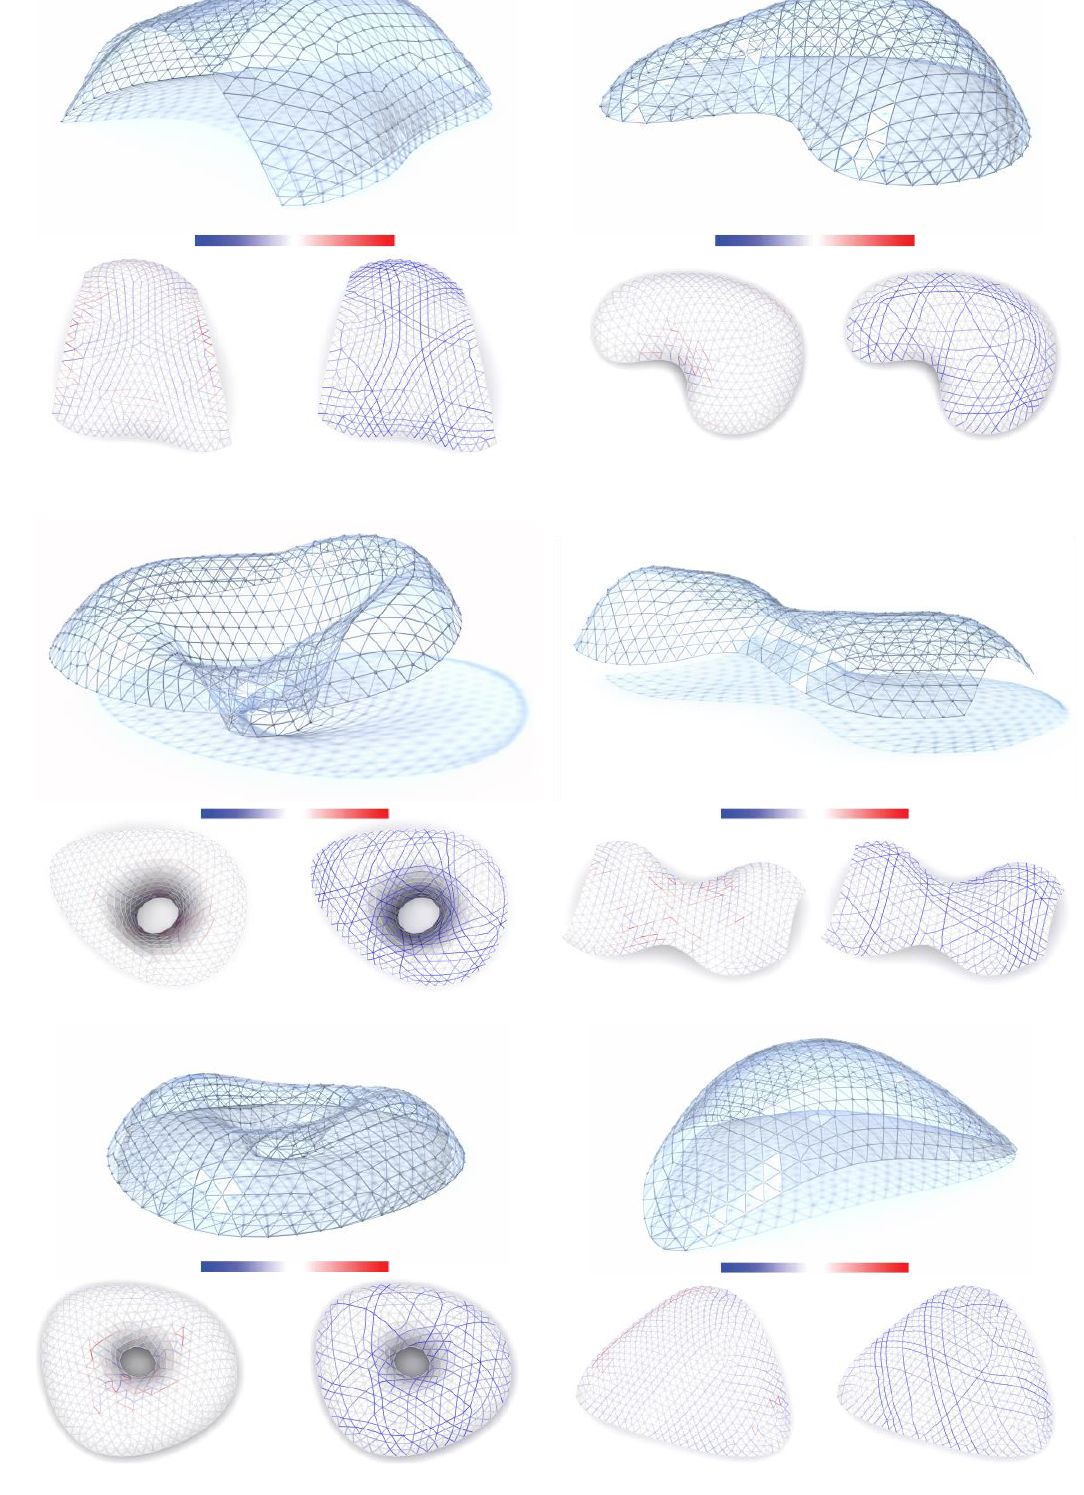
Fig. 7 Results of the optimization